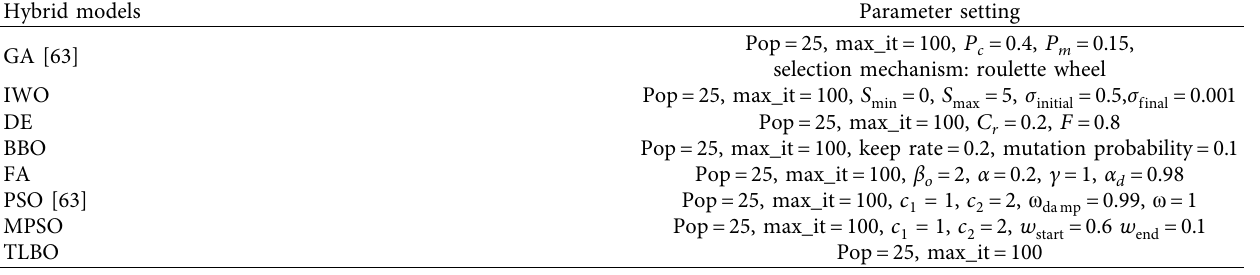
Table 2: Parameters setup for the algorithms.